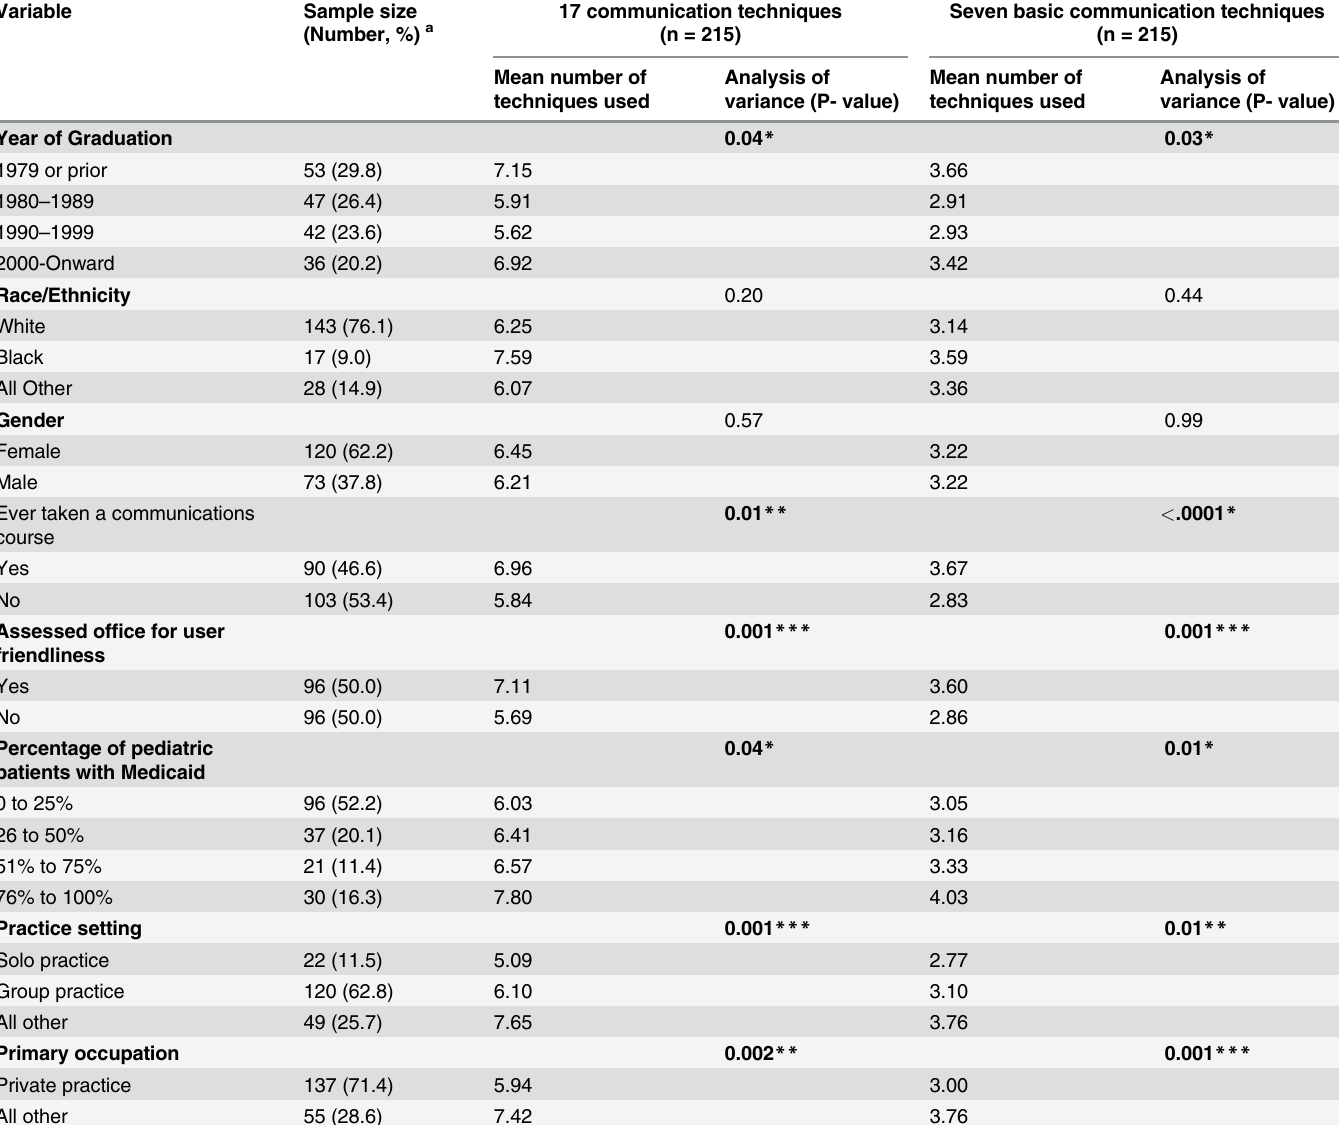
Table 6. Bivariate analysis of predictor variables and mean communication techniques used routinely by pediatricians.